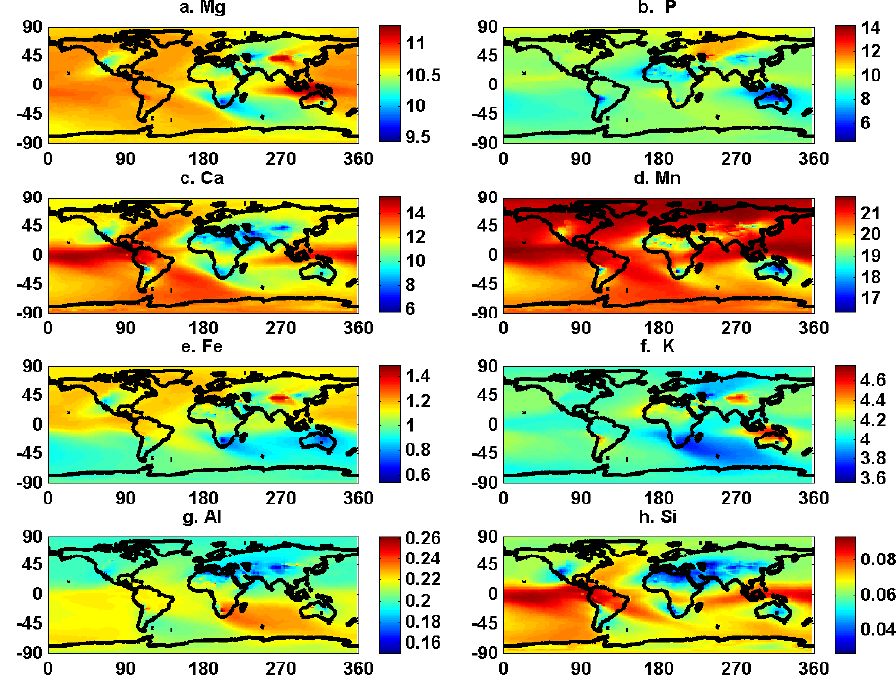
Figure 14. Fractional solubility of elements (soluble element / total element) in dust deposition (%): (a) Mg, (b) P, (c) Ca, (d) Mn, (e) Fe, (f) K, (g) Al, (h)